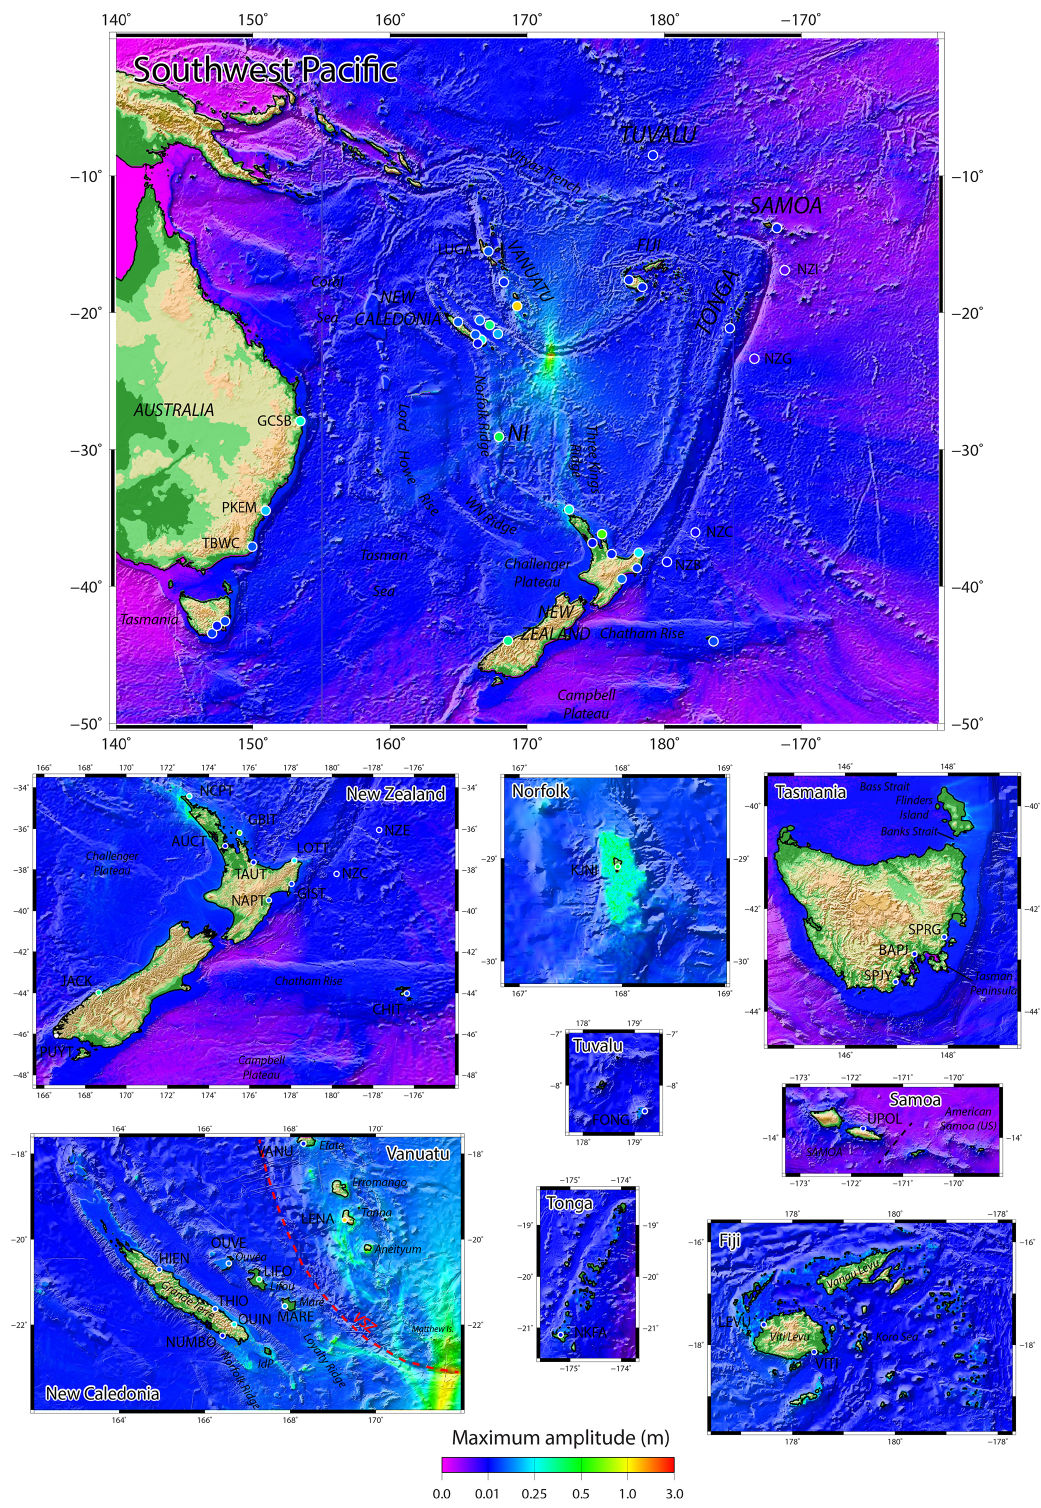
Figure 11. Maximum wave amplitude maps obtained after 12h of simulated tsunami propagation for the 10 February 2021 with a non- uniform slip model from waveform inversion (Gusman et al., 2022). The coloured circles locate the coastal gauges and DART stations having recorded the tsunami and used in this study, the colouration being linked to the maximum amplitude reported in Table 2. IdP: Isle of Pines, NI: Norfolk Island, NW Ridge: West Norfolk Ridge, VSZ: Vanuatu subduction zone (red dashed line).